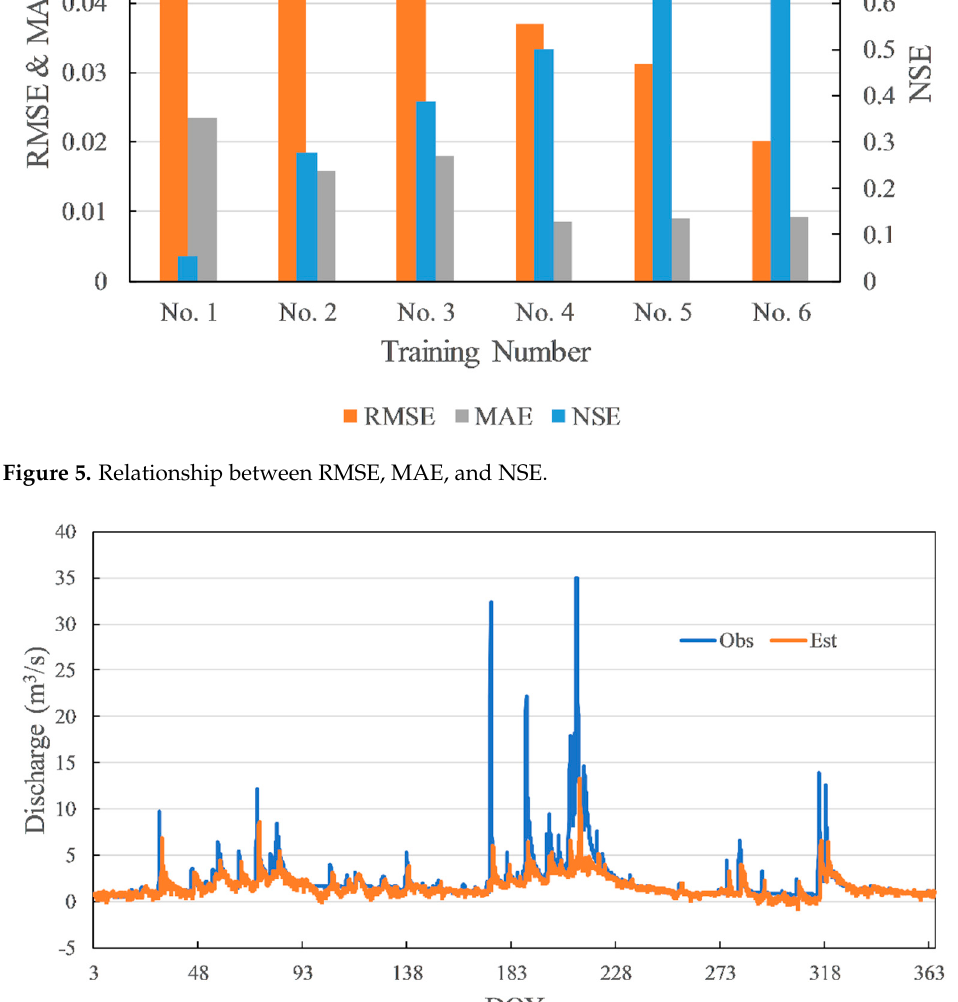
Figure 6. Hydrograph of Training No. 2.